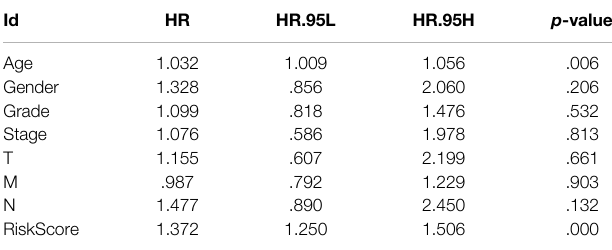
TABLE 4 | Multivariate Cox regression analysis of clinical characteristics and the risk score for PAAD.